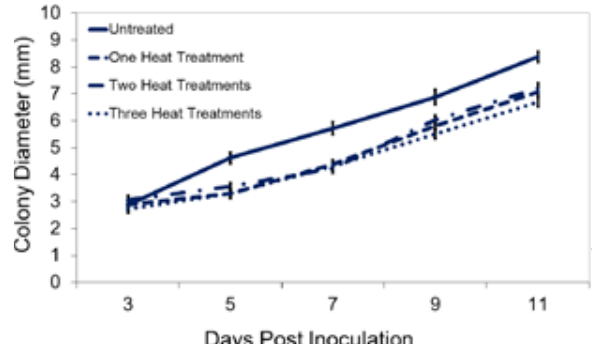
Figure 3. Colony diameter growth of Erysiphe necator on live plants for different heat exposure groups at 37°C. Points represent true means ± the standard error of the